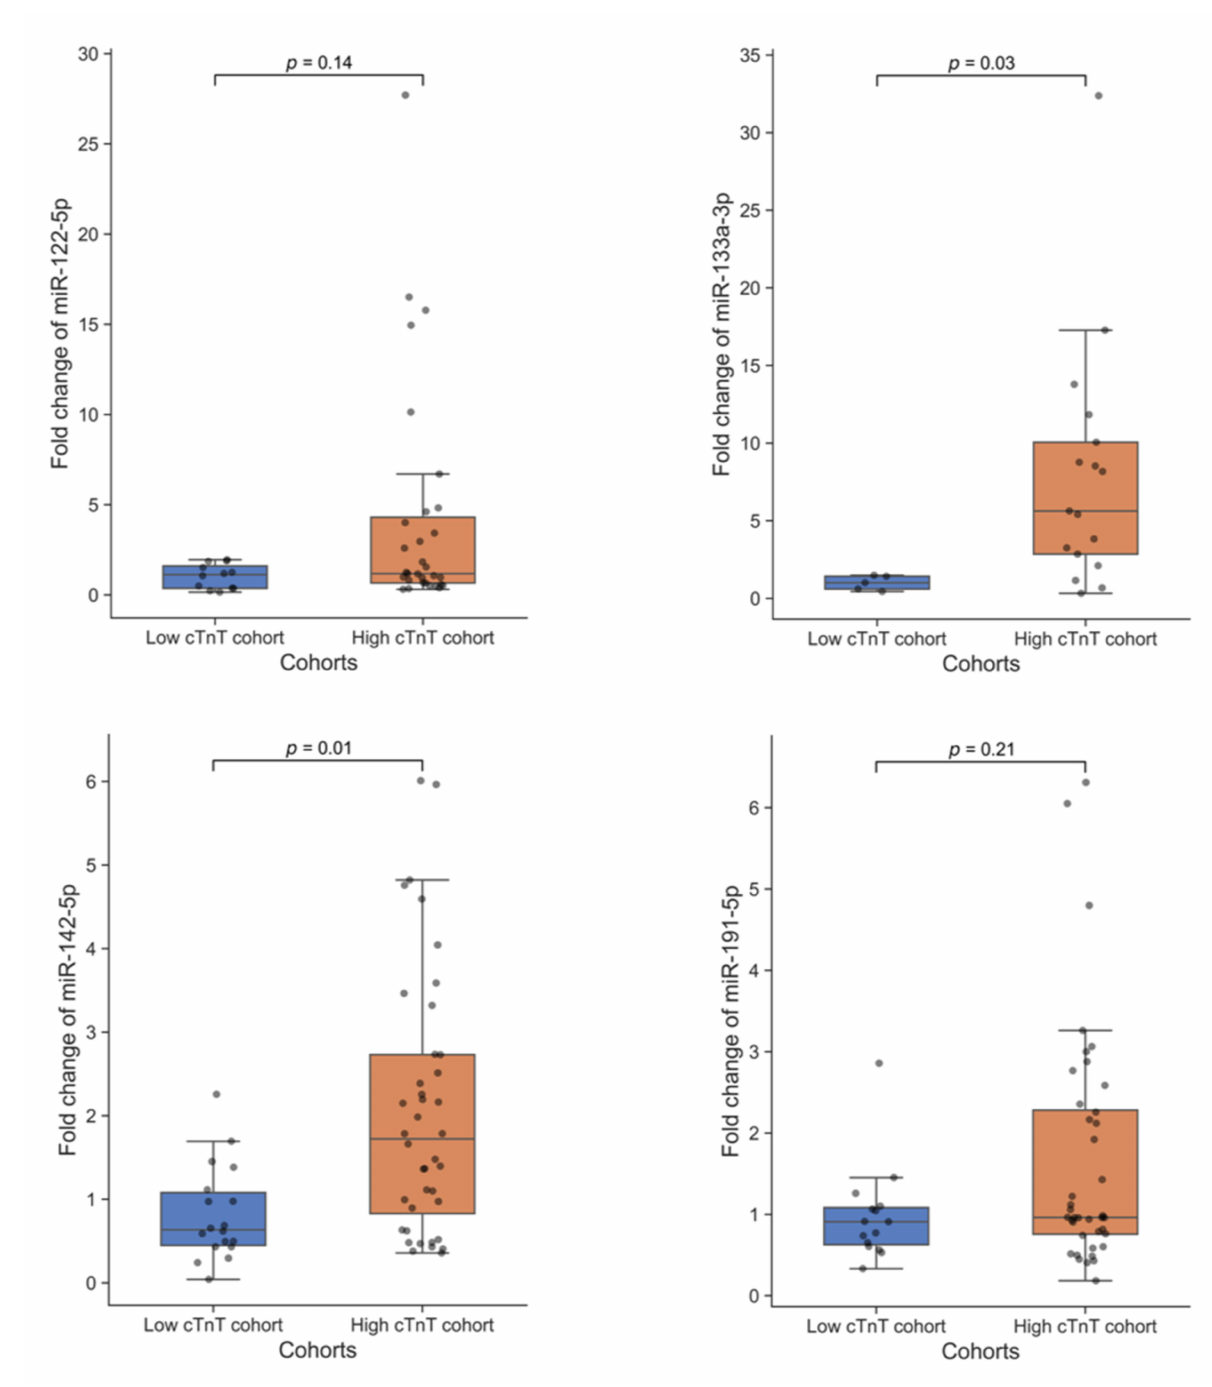
Figure 4. Fold change differences of microRNAs between the low and high cTnT cohort. Com- paring central tendencies of microRNA fold changes between the low and high cTnT cohort, three microRNAs are upregulated in patients with elevated cTnT concentrations, none is downregulated, and three are not significantly different. The two-sided Mann–Whitney U test (exact p -value) was applied. Adjustment of p -values for multiple testing was performed based on false discov- ery rate according to Benjamini and Hochberg. MicroRNA expressions for calculation of fold changes (see material and methods) were attained by means of quantitative real-time polymerase chain reaction. Abbreviation: cTnT, cardiac troponin